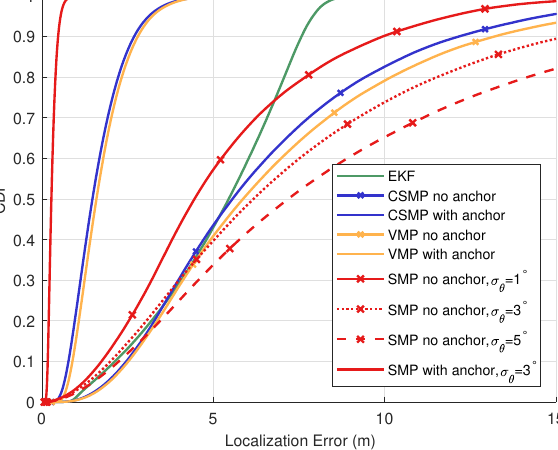
Figure 5. Graphical simulator.